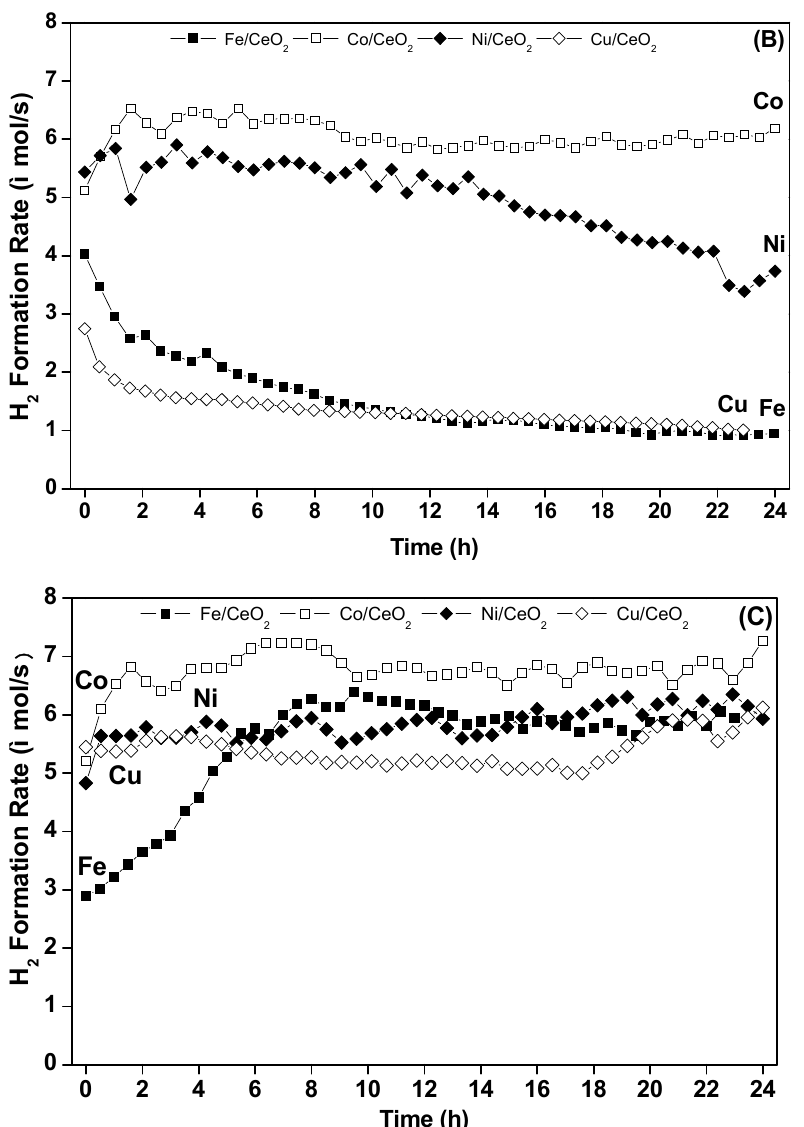
Figure 10. Stability performance of M/CeO 2 catalysts (M: Fe, Co, Ni, Cu) at 400 °C ( A ); 600 °C ( B ) and 800 °C ( C ) during ESR. Reaction conditions: S/C=3, m cat = 250 mg, F T = 150 cm 3 /min.